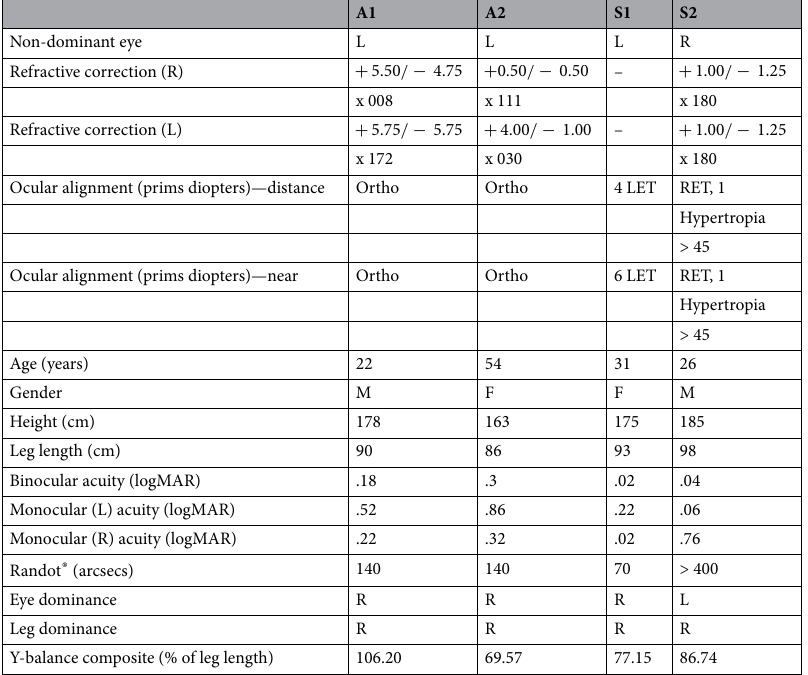
Table 2. Participant visual and demographic characteristics—individuals with amblyopia (A) and/or strabismus